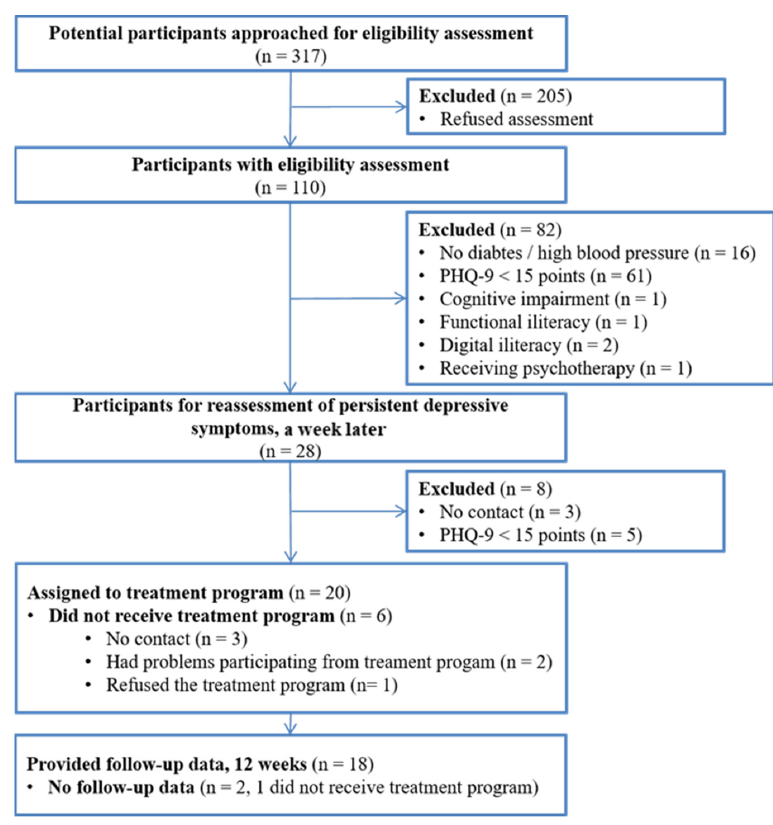
Figure 1. Study flow diagram. Table 2. Personal and family health history for the